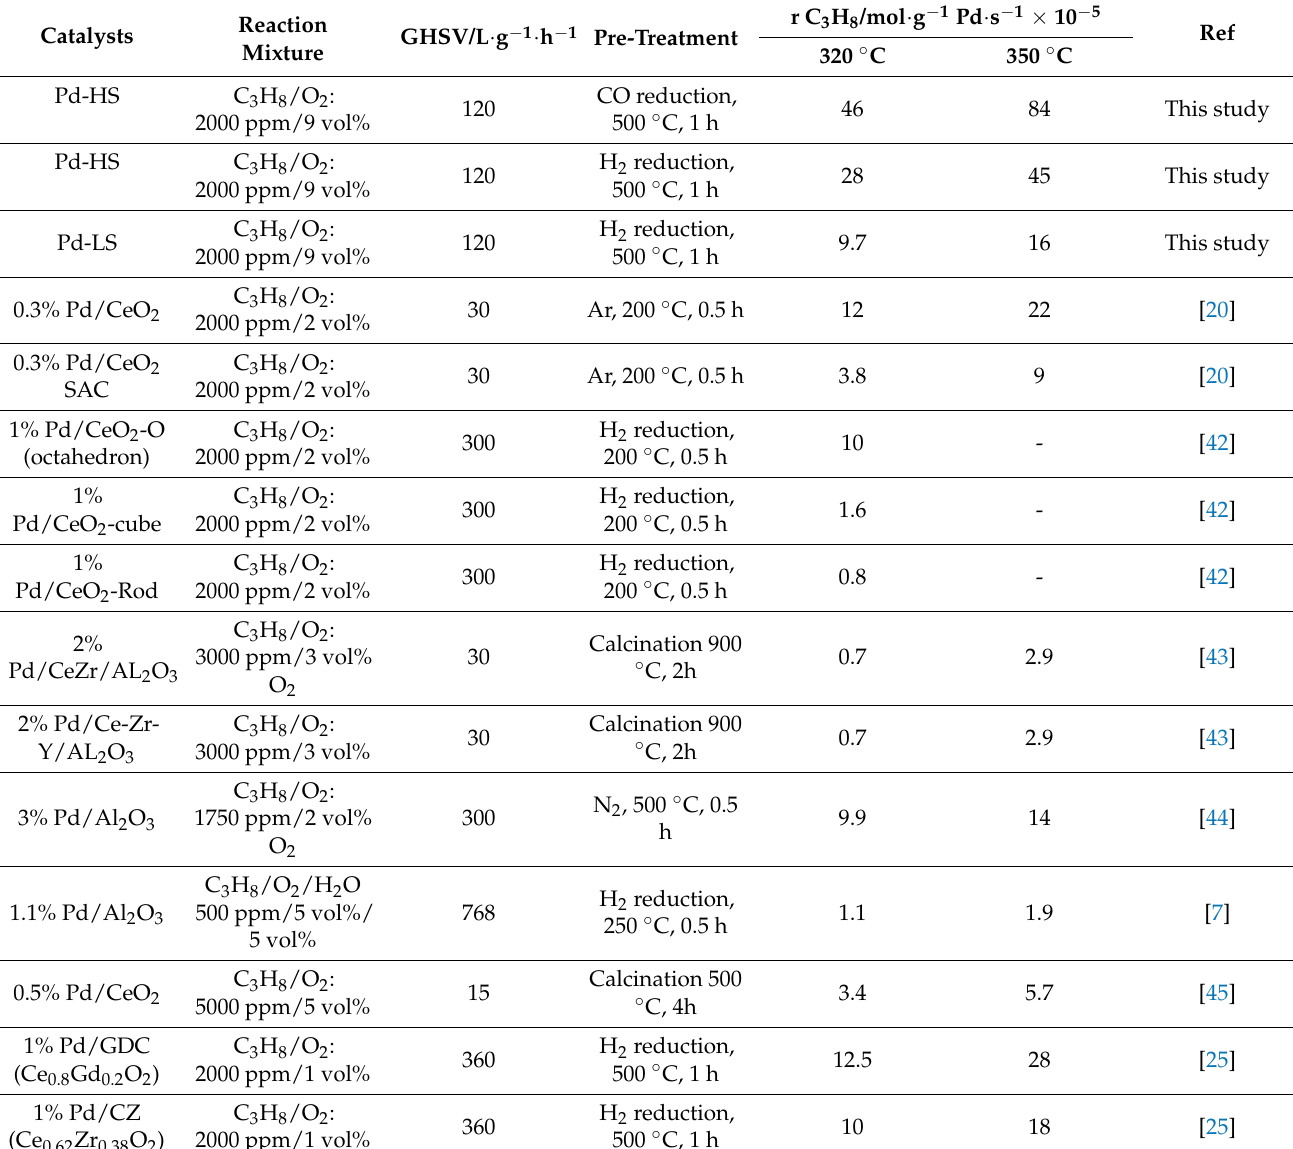
Table 6. Catalytic activity for C 3 H 8 oxidation and comparison with the literature